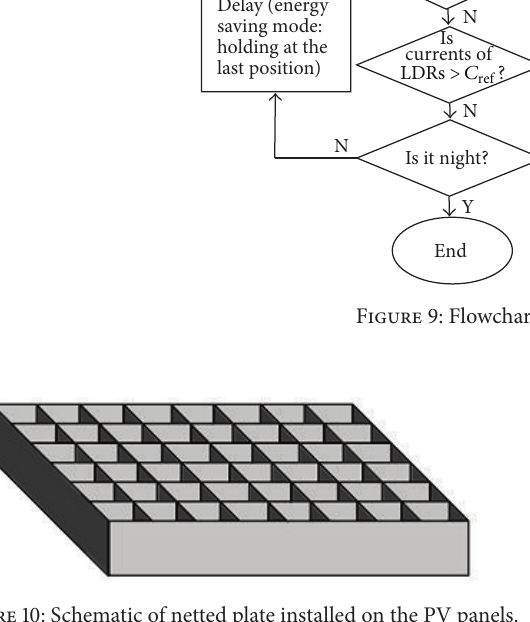
Figure 10: Schematic of netted plate installed on the PV panels.